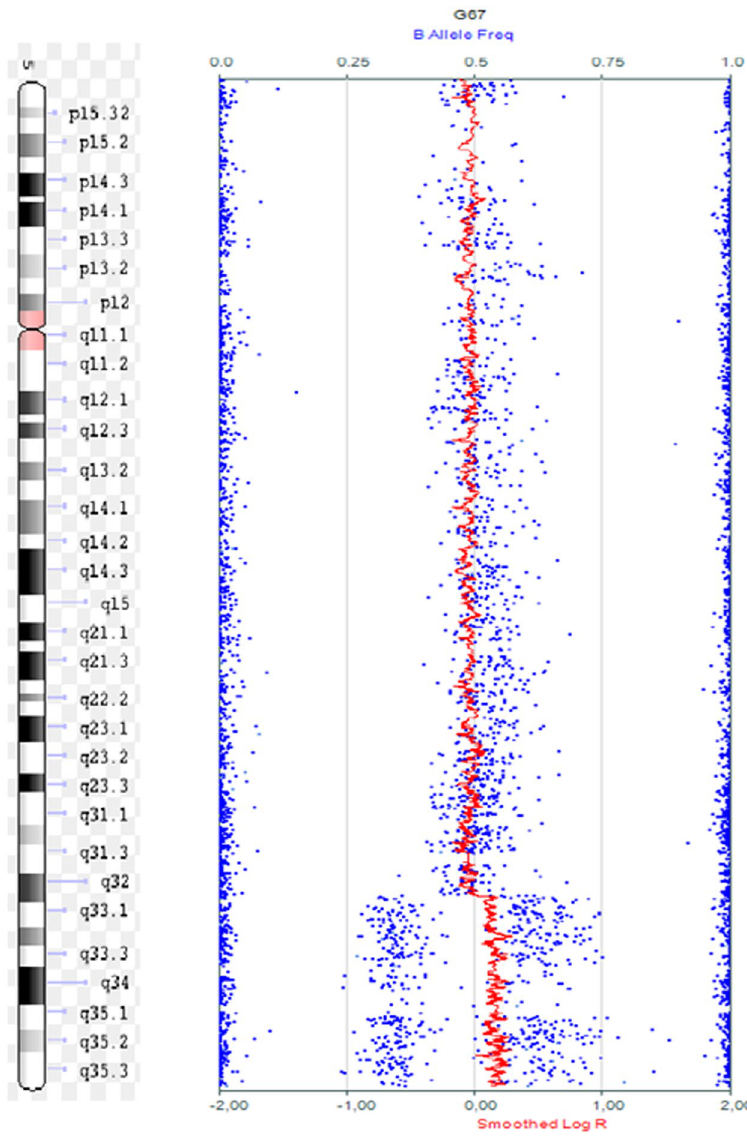
Figure 2. SNP-array showing duplication 5q34q35.3